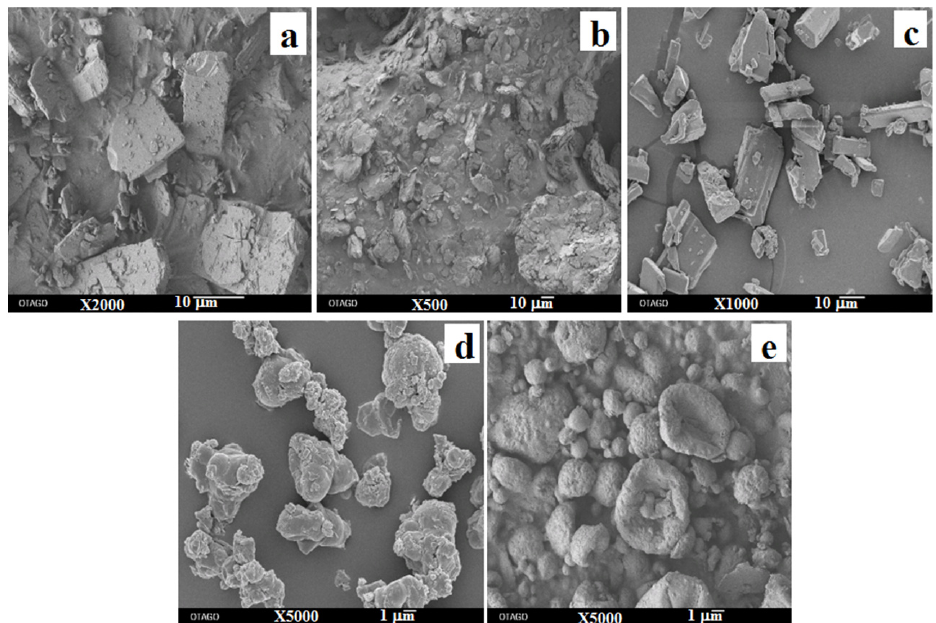
Figure 4. Representative scanning electron micrographs of: ( a ) supplied roflumilast; ( b ) supplied L ‐ leucine; ( c ) supplied trehalose; ( d ) spray ‐ dried roflumilast ‐ only; and ( e ) spray ‐ dried roflumilast with L ‐ leucine and trehalose powders.